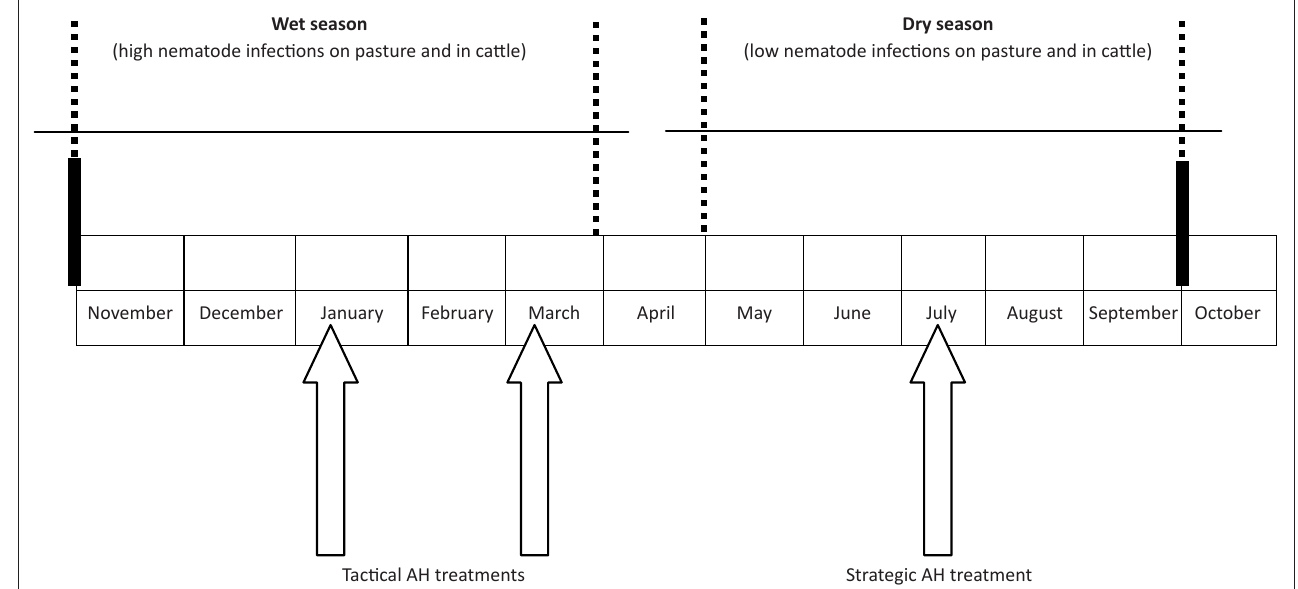
FIGURE 1: Seasonal occurrence of gastrointestinal nematode infections in cattle in Zimbabwe based on epidemiological reports and the recommended treatment